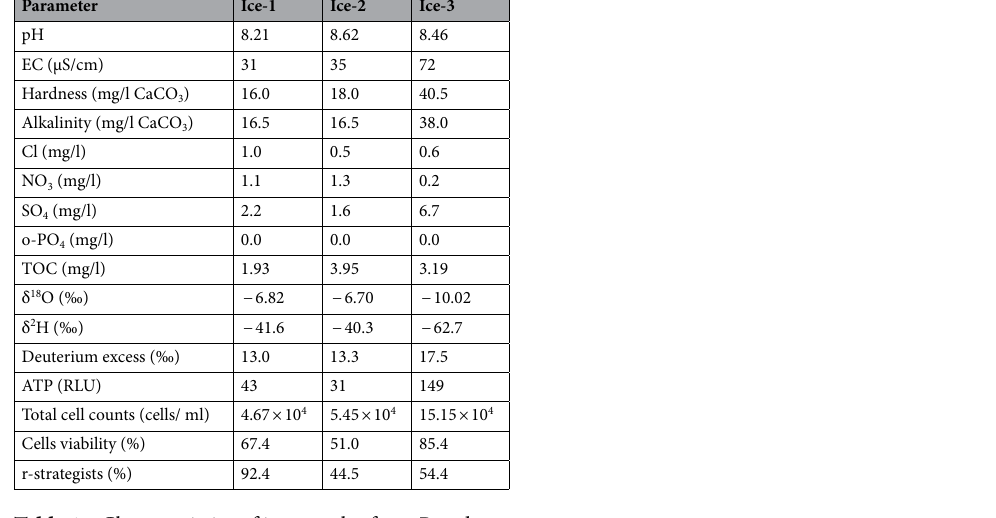
Table 1. Characteristics of ice samples from